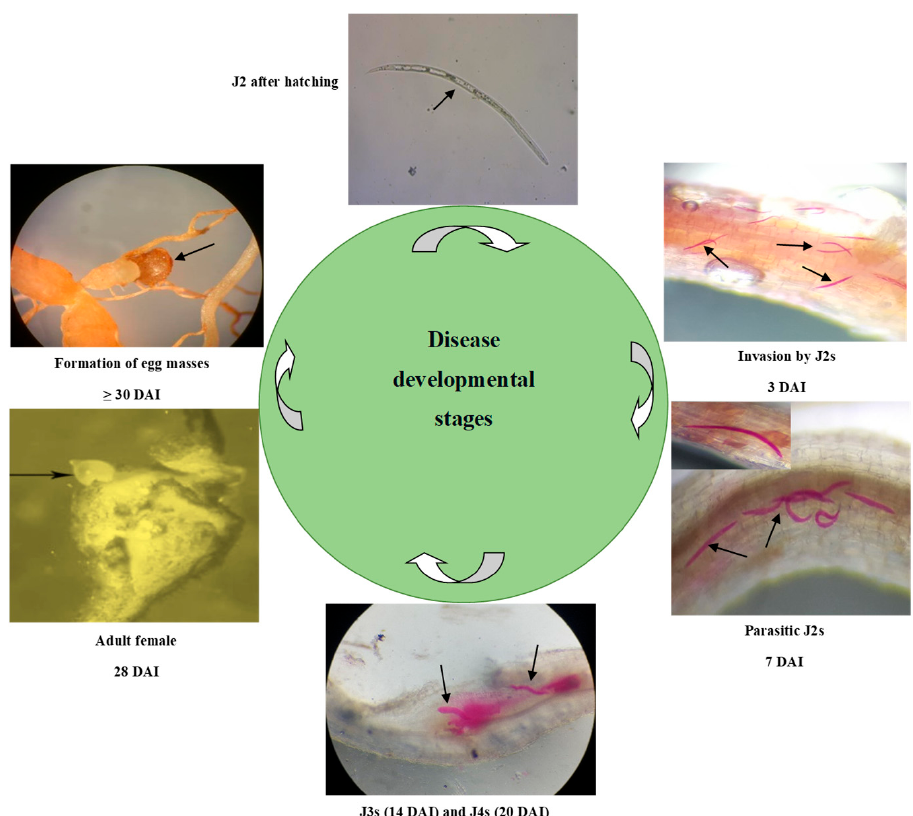
Figure 2. Meloidogyne javanica life cycle in the roots of the highly susceptible tomato cultivar, Dutch Mobil. The highest number of invasive J2s, parasitic J2s, J3s, J4s, and adult females in Dutch Mobil were observed at 3, 7, 14, 20, and 28 DAI, respectively. Arrows show the life stages of the nematode in the root. Roots were stained with acid-fuchsin. J2s, J3s, and J4s: juveniles in the second, third, and fourth stages of development, respectively; DAI: days after